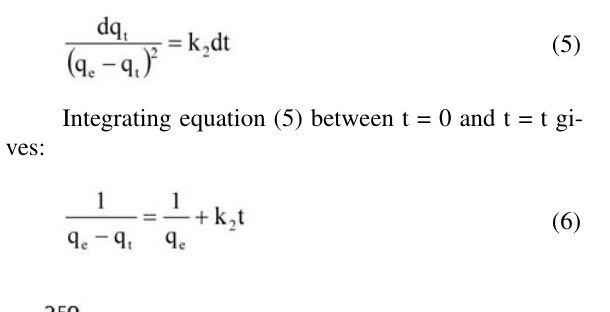
Fig. 6. Plots of the pseudo-second-order kinetic models for Cd 2+ bioadsorption on waste brewery yeast biomass; C mass per volume), 23 °C, pH 5.6, 150 rpm.